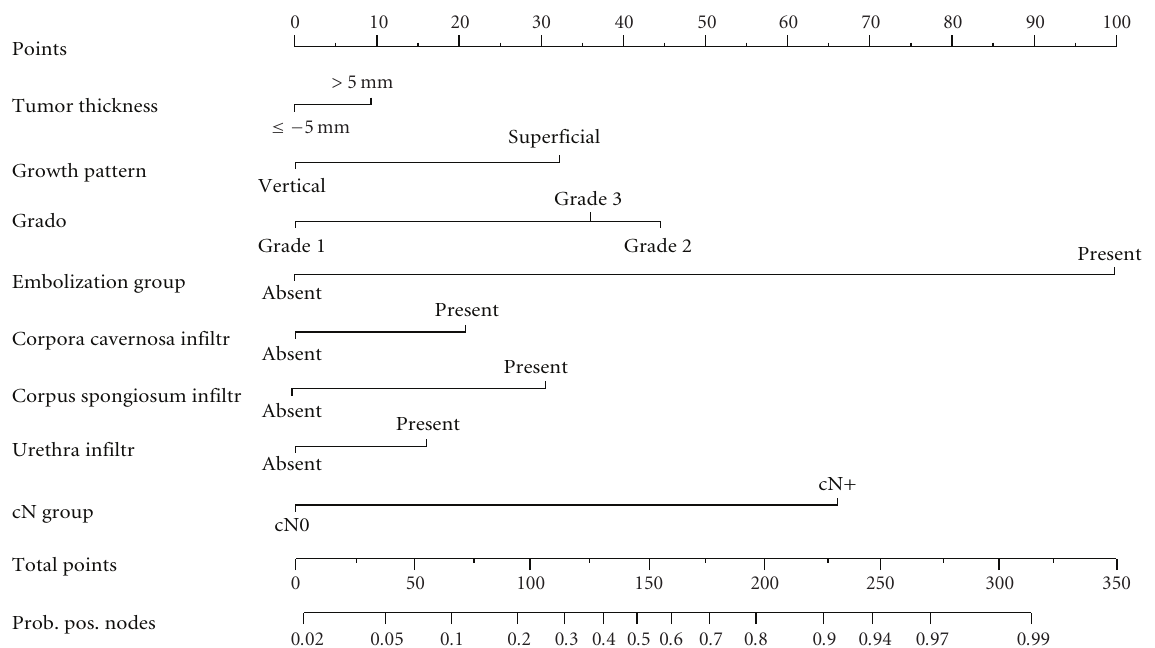
Figure 1: Nomogram predicting the probability of lymph node metastasis for penile cancer. Reprinted with permission from: Ficarra et al.